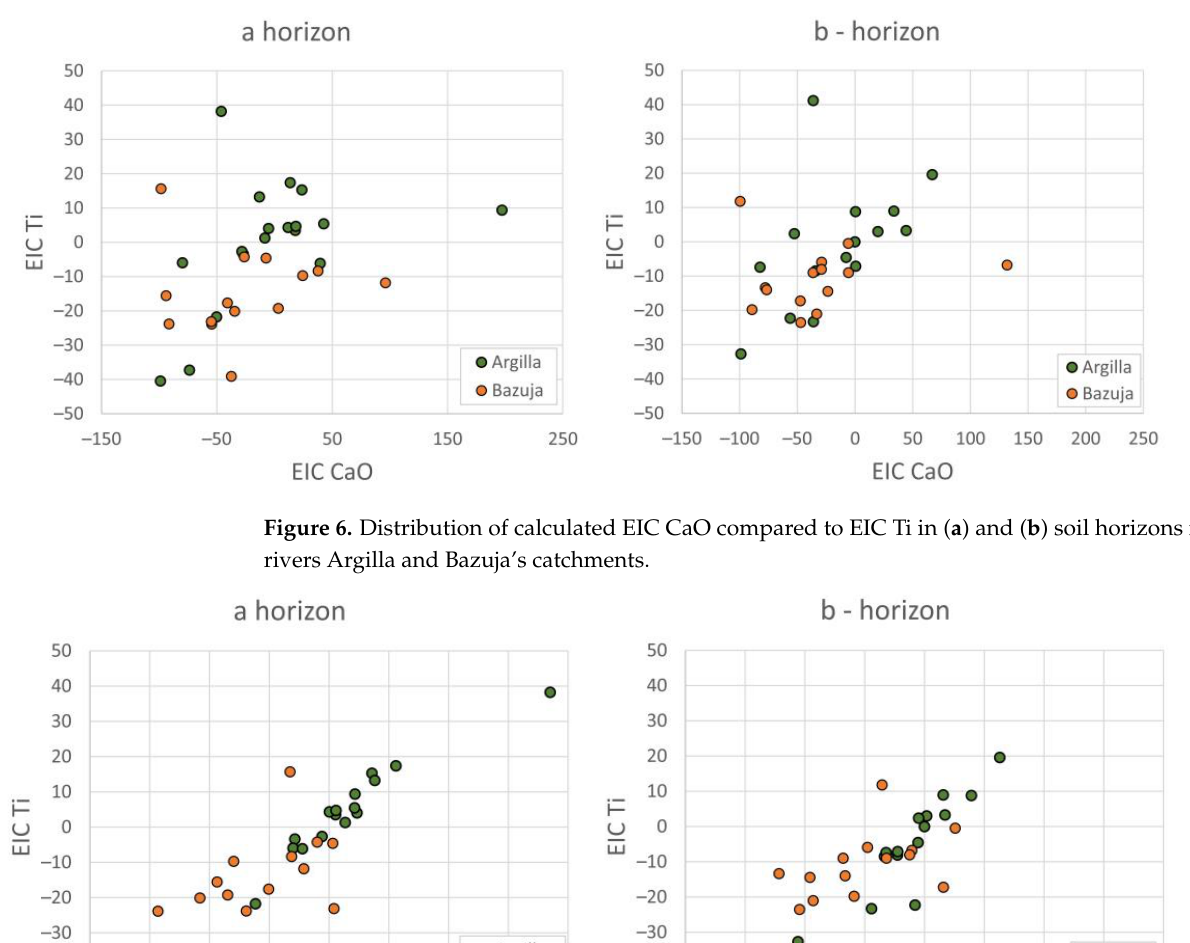
Figure 5. Distribution of calculated EIC MgO compared to EIC Ti in ( a ) and ( b ) soil horizons in the rivers Argilla and Bazuja’s catchments.